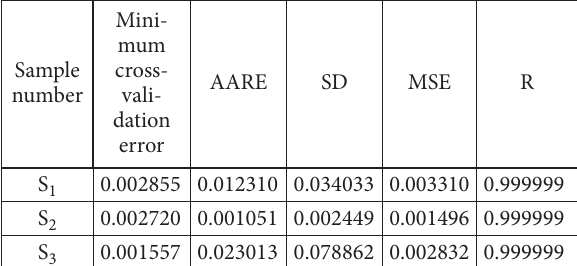
Table 5. Results related to the prediction using LM algorithm Mini- mum Sam ple cross- AARE num ber vali- dation error